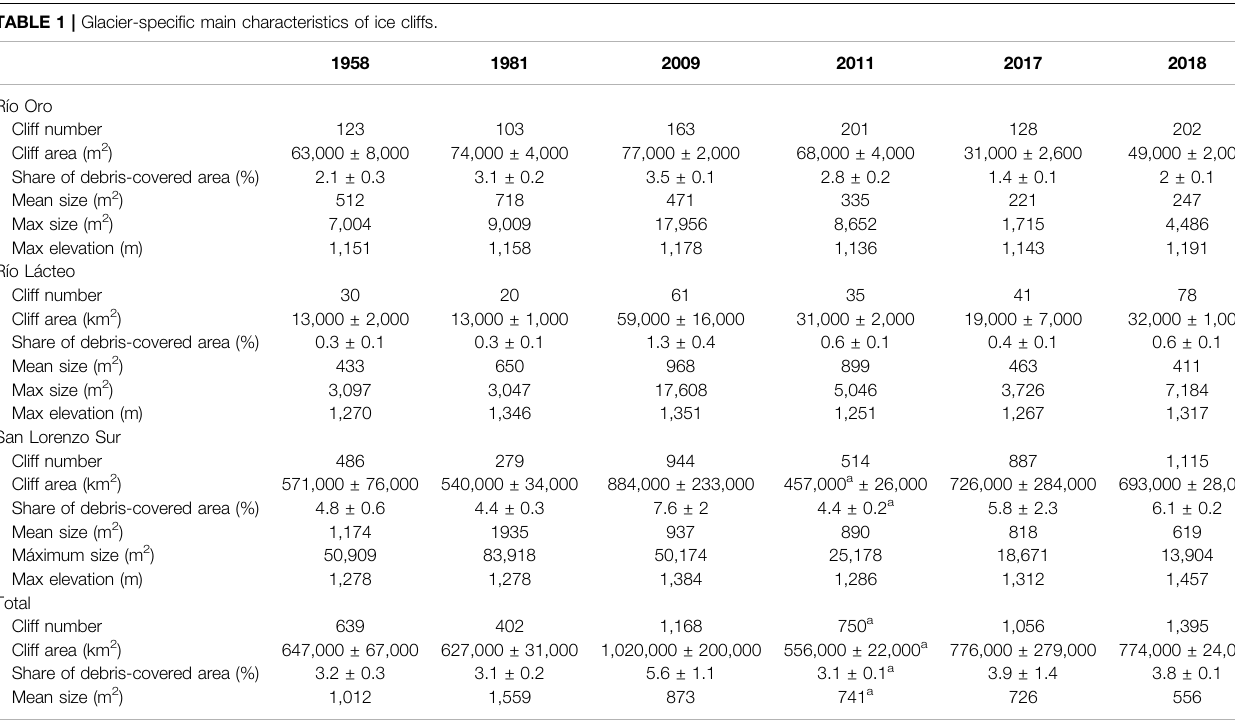
TABLE 1 | Glacier-speci fi c main characteristics of ice